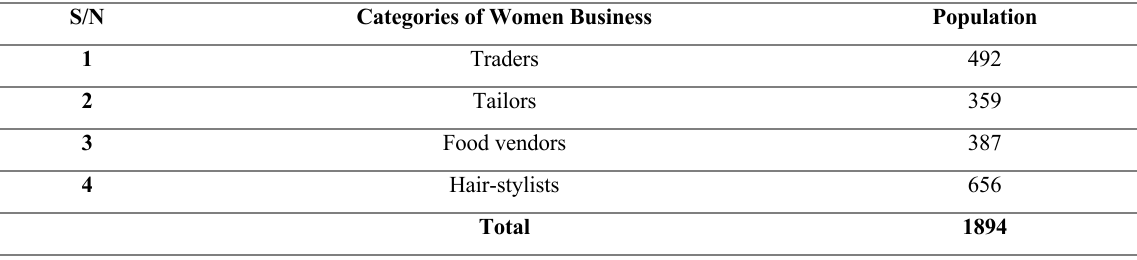
Table 1: Population Selected Women Business in Jos, Plateau State